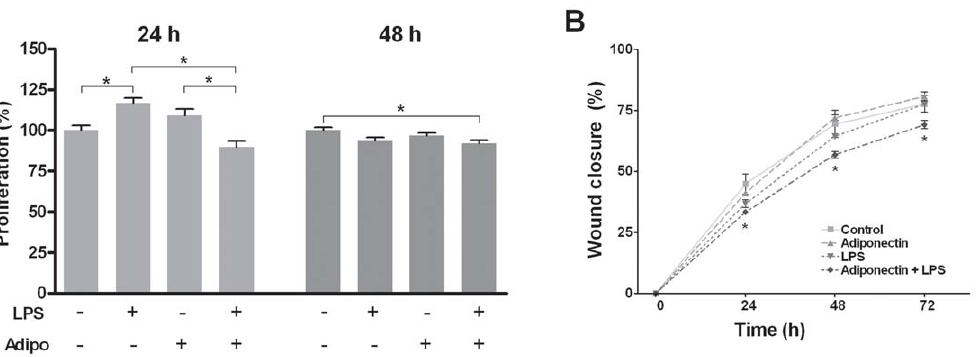
Figure 6. Interactions of lipopolysaccharide and adiponectin on proliferation and wound closure. Effects of lipopolysaccharide (LPS; 2 m g/ml) and/or adiponectin (Adipo; 1 m g/ml) on the proliferation at 24 h and 48 h (A) and wound closure over 72 h (B). Mean 6 SEM; * p , 0.05 difference between groups (A) and difference between cells simultaneously treated with LPS and adiponectin, and control (A).